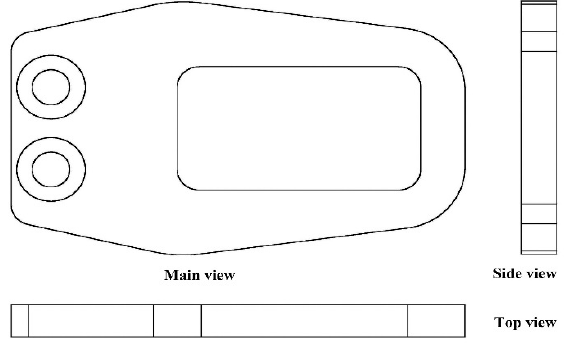
Figure 21. Optimized structure of the wheelset lifting mechanism.